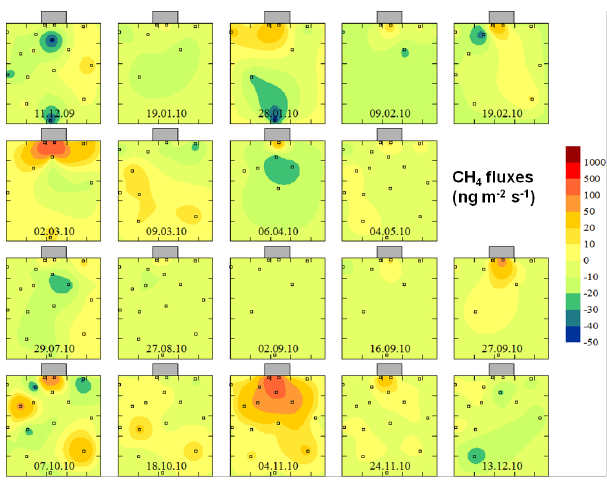
Fig. 4. Spatially interpolated (kriging method) maps of CH 4 fluxes. Comments as in Fig. 3.